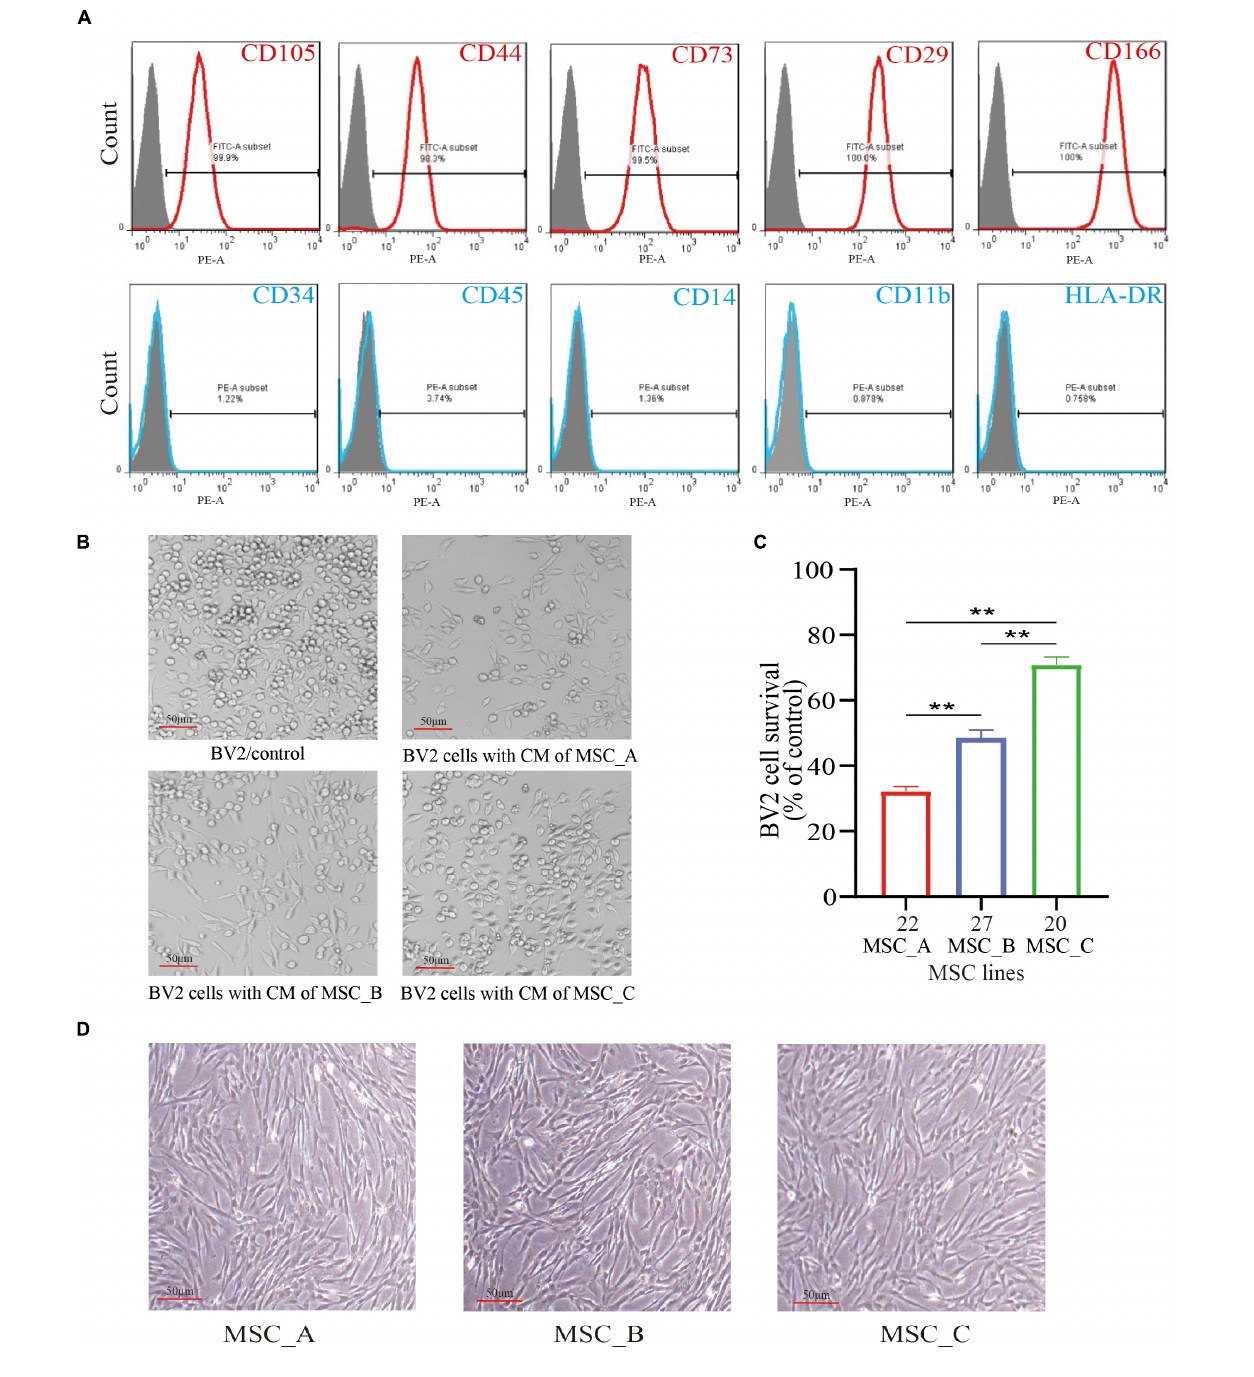
FIGURE 1 | Culture, identification, and selection of human umbilical cord mesenchymal stem cells (hUCMSCs). (A) Flow cytometry analysis of surface markers in hUCMSCs. (B) The BV2 cells were cultured with the culture medium (CM) of MSC_A, MSC_B, and MSC_C for 48h. (C) Different lines of hUCMSCs had different inhibitory abilities on the proliferation rate of BV2 cells. (D) The three lines of hUCMSCs attached to the wall and sprawled out, which exhibited a fibroblast-like shape. All data are presented as the mean ± SEM; n = 3; * p < 0.05; ** p < 0.01.